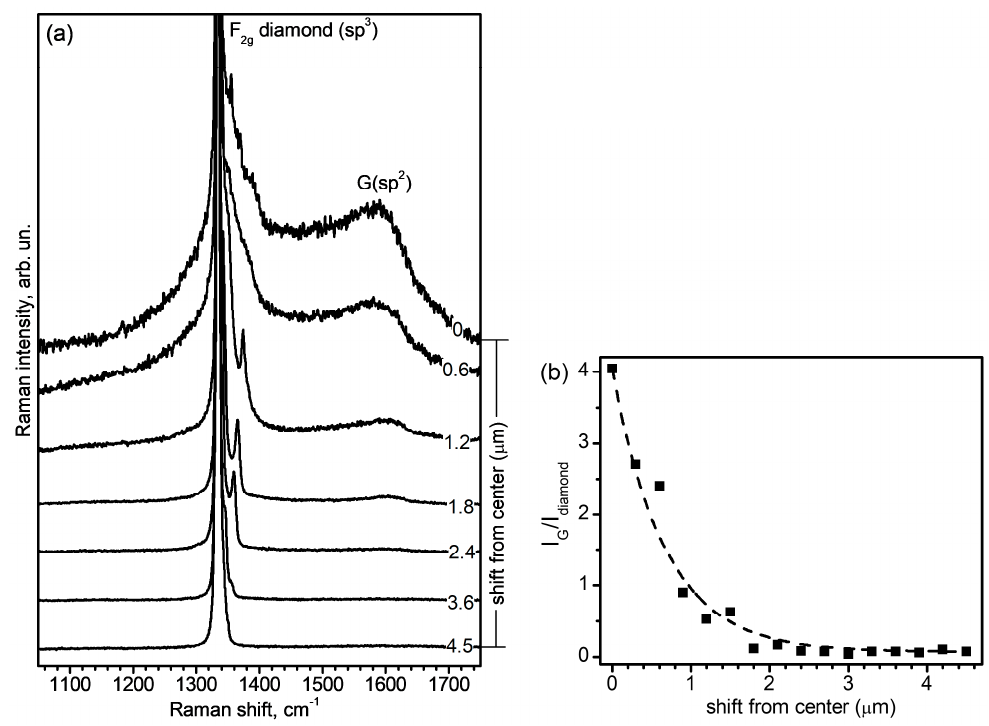
Figure 4. ( a ) Set of Raman spectra and ( b ) I G /I diamond intensity ratio obtained by lateral scanning across the Vickers indent in diamond from its center to edge. The dashed line is shown to guide the